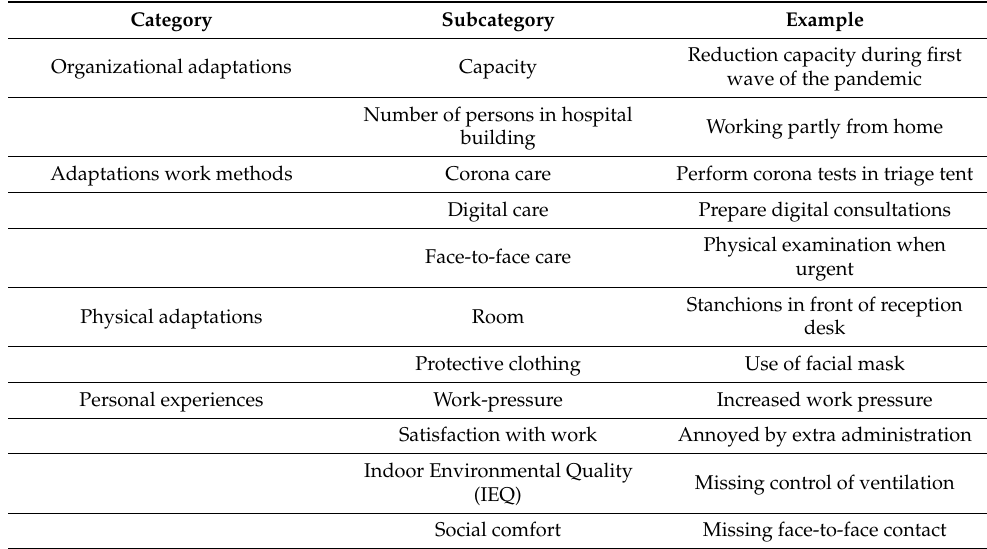
Table 3. Data structure of the changes related to the coronavirus disease 2019 (COVID-19)